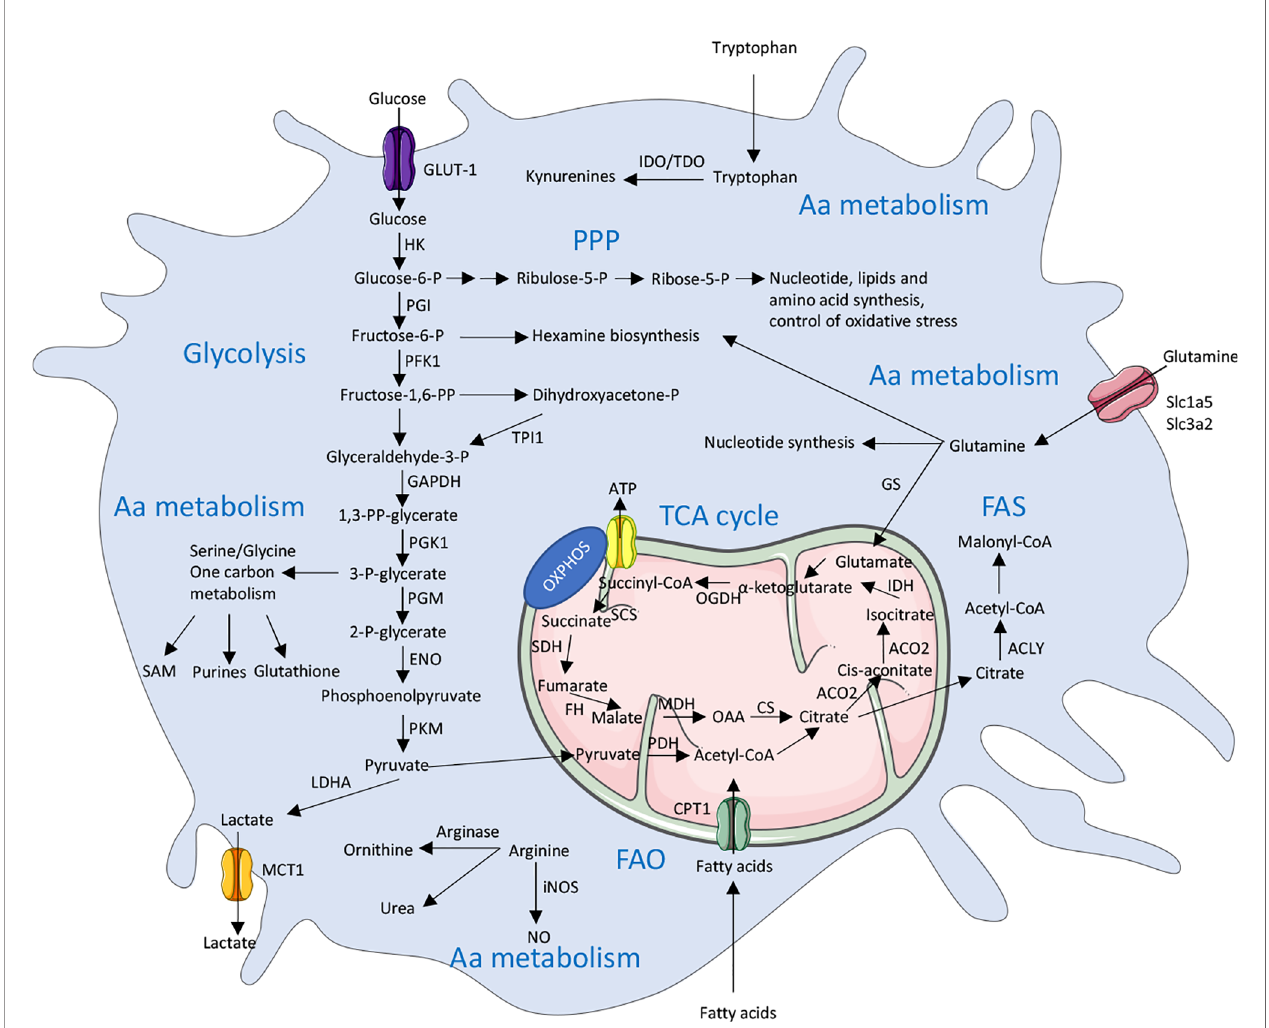
FIGURE 1 | Overview of the main metabolic pathways used by macrophages. There are 5 major pathways used by macrophages to provide energy in cells including glycolysis, TCA (Tricarboxylic acid) cycle, PPP (Pentose phosphate pathway), FAS (Fatty acid synthesis) and FAO (Fatty acid oxidation) and amino acid (Aa) metabolism. These pathways are highly interconnected and are tightly regulated in immune cells, including macrophages. ACLY, ATP citrate lyase; ACO2, Aconitase 2; ATP, Adenosine triphosphate; CPT1, Carnitine palmitoyltransferase 1; CS, Citrate synthase; ENO, Enolase; FH, Fumarase; GAPDH, Glyceraldehyde 3-phosphate dehydrogenase; GLUT1, Glucose transporter 1; HK, Hexokinase; GS, Glutamine synthetase; IDH, Isocitrate dehydrogenase; IDO, Indoleamine 2,3-dioxygenase; LDHA, Lactate dehydrogenase; MCT1, Monocarboxylate transporter 1; MDH, Malate dehydrogenase; NO, Nitric oxide; iNOS, inducible NO synthase; OAA, Oxaloacetate; OGDH, a -ketoglutarate dehydrogenase; OXPHOS, Oxidative phosphorylation; P, Phosphate; PDH, Pyruvate dehydrogenase; PFK1,Phosphofructokinase 1; PGK1, Phosphoglycerate kinase 1; PGI, Phosphoglucoisomerase; PGM, Phosphoglycerate mutase; PKM, Pyruvate kinase muscle isotype; PP, bisphosphate; SAM, S-Adenosyl methionine; SCS, Succinyl coenzyme A synthetase; SDH, Succinate dehydrogenase; SLC, Solute carrier; TDO, Tryptophan 2,3-dioxygenase; TPI1, Triosephosphate isomerase